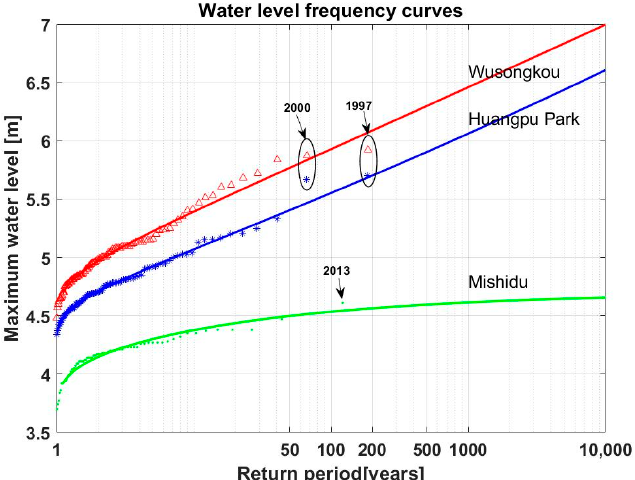
Figure 5. Water level-frequency curves for three hydrological stations: Wusongkou, Huangpu Park and Mishidu, along the Huangpu River (the highest and second highest records and the recorded year at Wusongkou and Huangpu Park are shown by means of ellipse). Table 3. Results of the statistical performance indicator (Chi-Square test, K-S test and MSD) with three parameter estimation methods (LMM, MLE, LSE) for GEV and P-III distributions at the locations of Wusongkou, Huangpu Park and Mishidu (the selected results are highlighted in grey). Probability Distribution GEV P-III Critical Value